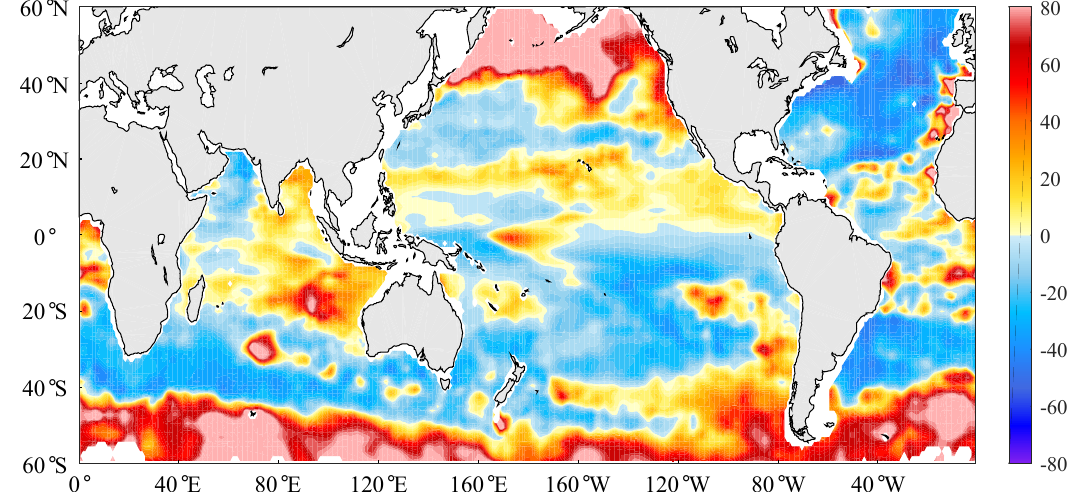
Figure 6. FOV of HSLA to the SSLA, during 2005 to 2015. Percentages (FOV X 100) shown here are used to illustrate the relative contribution of the halosteric component.